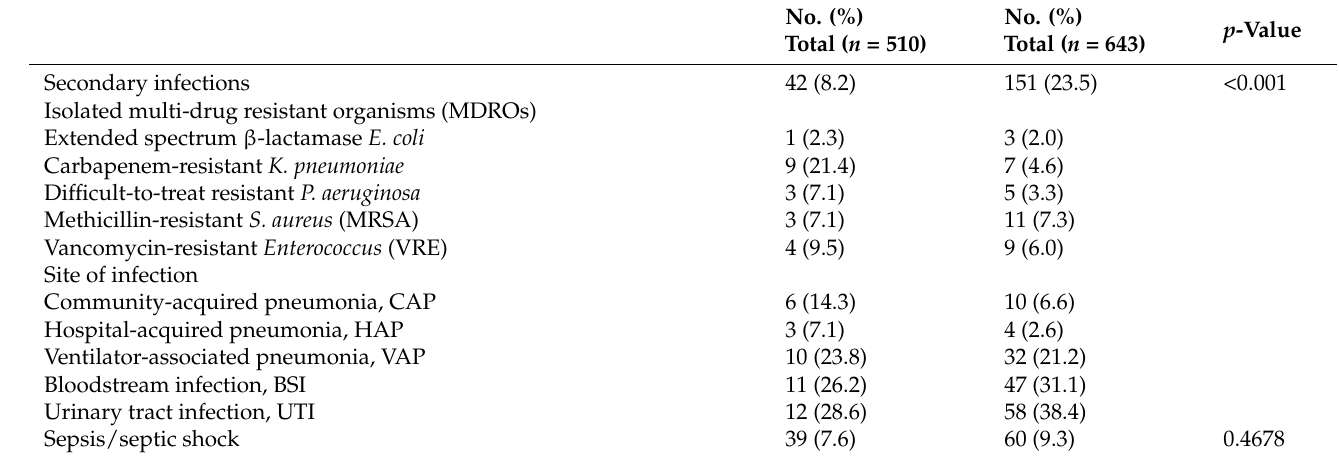
Table 2. Rate of secondary infections and isolated MDROs of COVID-19 patients admitted to IRCCS Humanitas Research Hospital. Dichotomous variables were analyzed with the Z-proportion